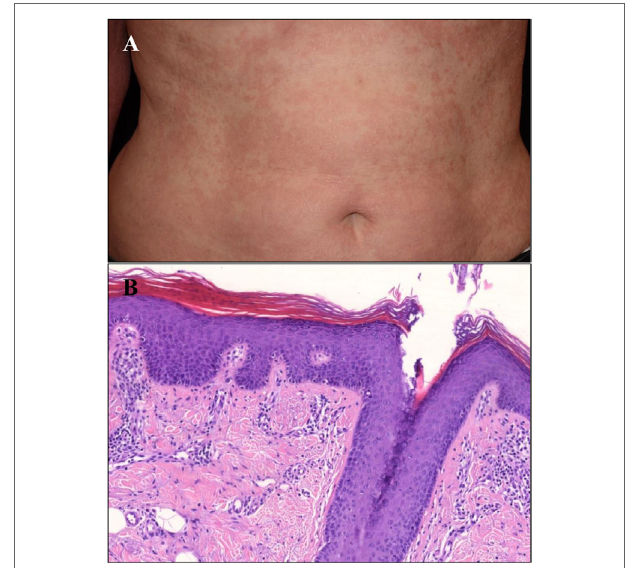
FIgURe 1 | Clinical and histological image of the type V Pityriasis rubra pilaris (PRP) patient. (a) Erythematosus, hyperkeratotic confluent thin plaques with fine scales on the trunk of the patient. (B) There is follicular plugging with alternating hyper­ and parakeratosis in the epidermis accompanied by granulosis, acanthosis, and mild spongiosis. A moderate lymphocytic infiltrate can be seen in the papillary dermis. The diagnosis of PRP has been confirmed by the histology (HE, digitally scanned